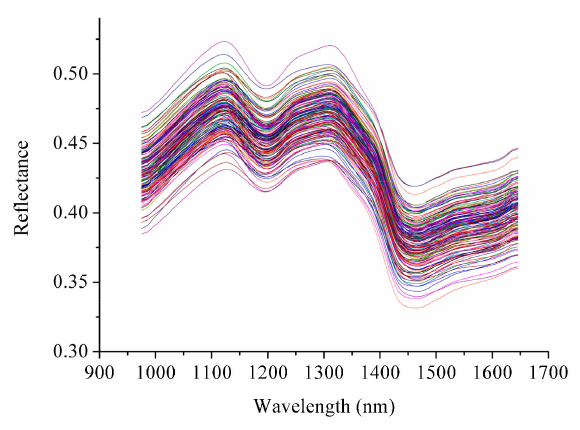
Figure 1. Spectra of Fritillaria thunbergii bulbi samples.